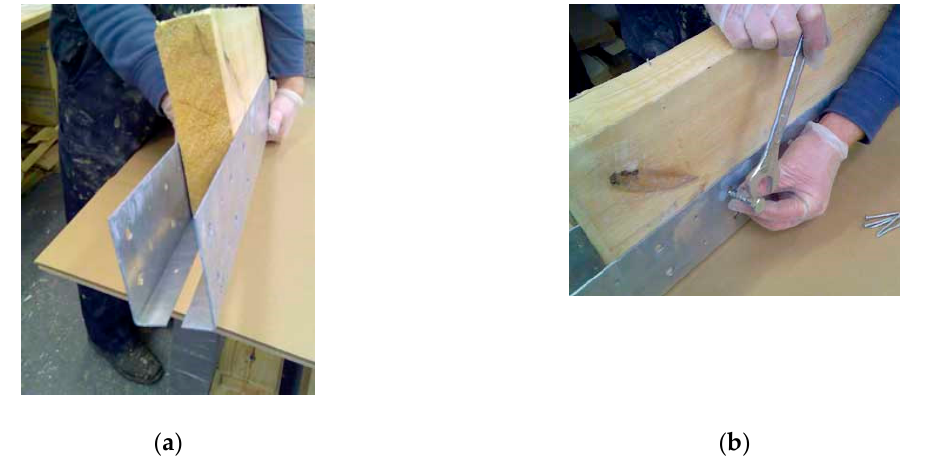
Figure 11. Re-construction of joist ends with stainless steel L-shaped profiles (press-bended stainless steel sheets) [43].